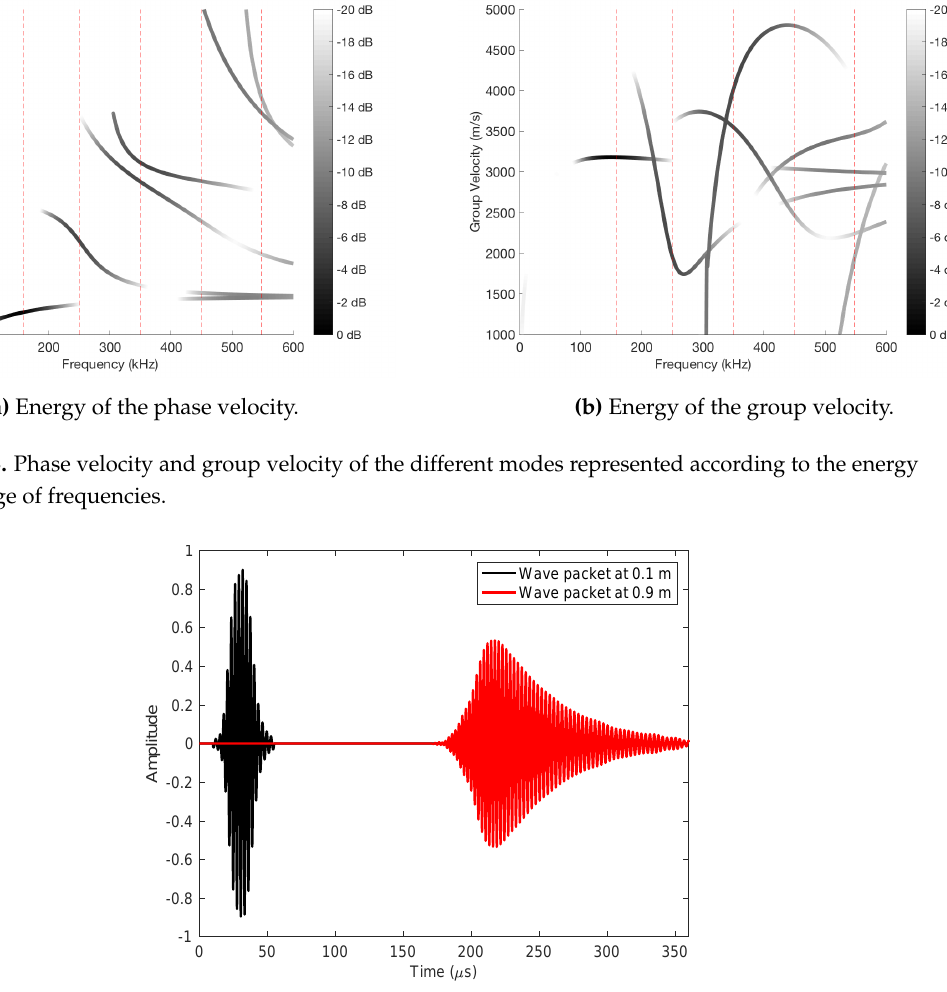
Figure 4. Dispersion suffered by the wave packet when traveling 0.8 m in the pipe (S0 mode, f = 300 kHz, C = 4